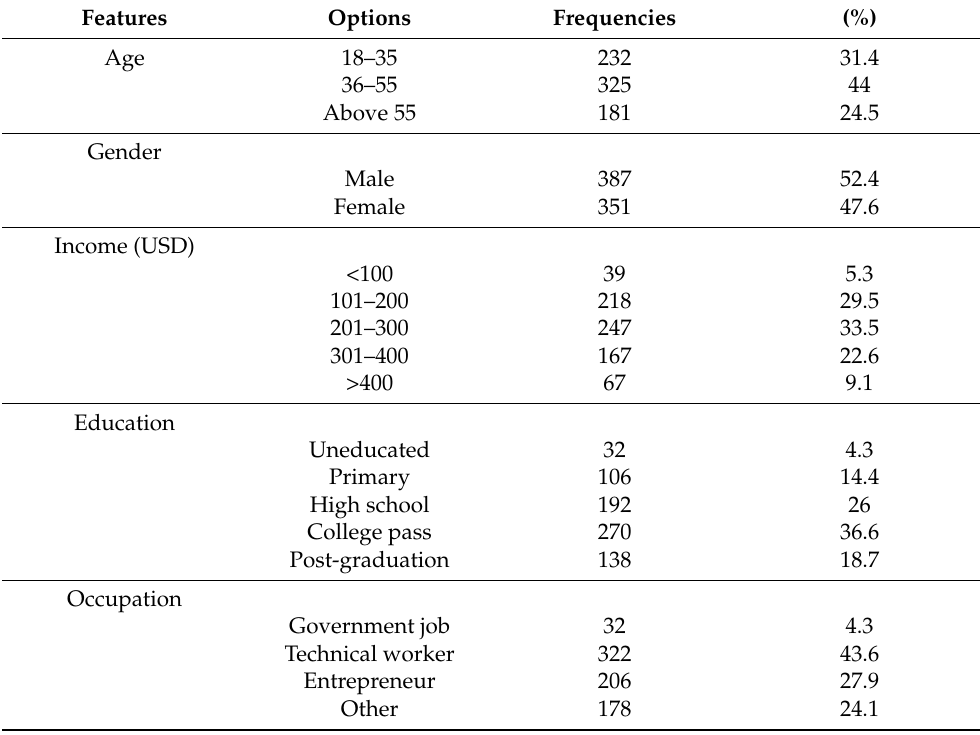
Table 2. Demography of the respondents.